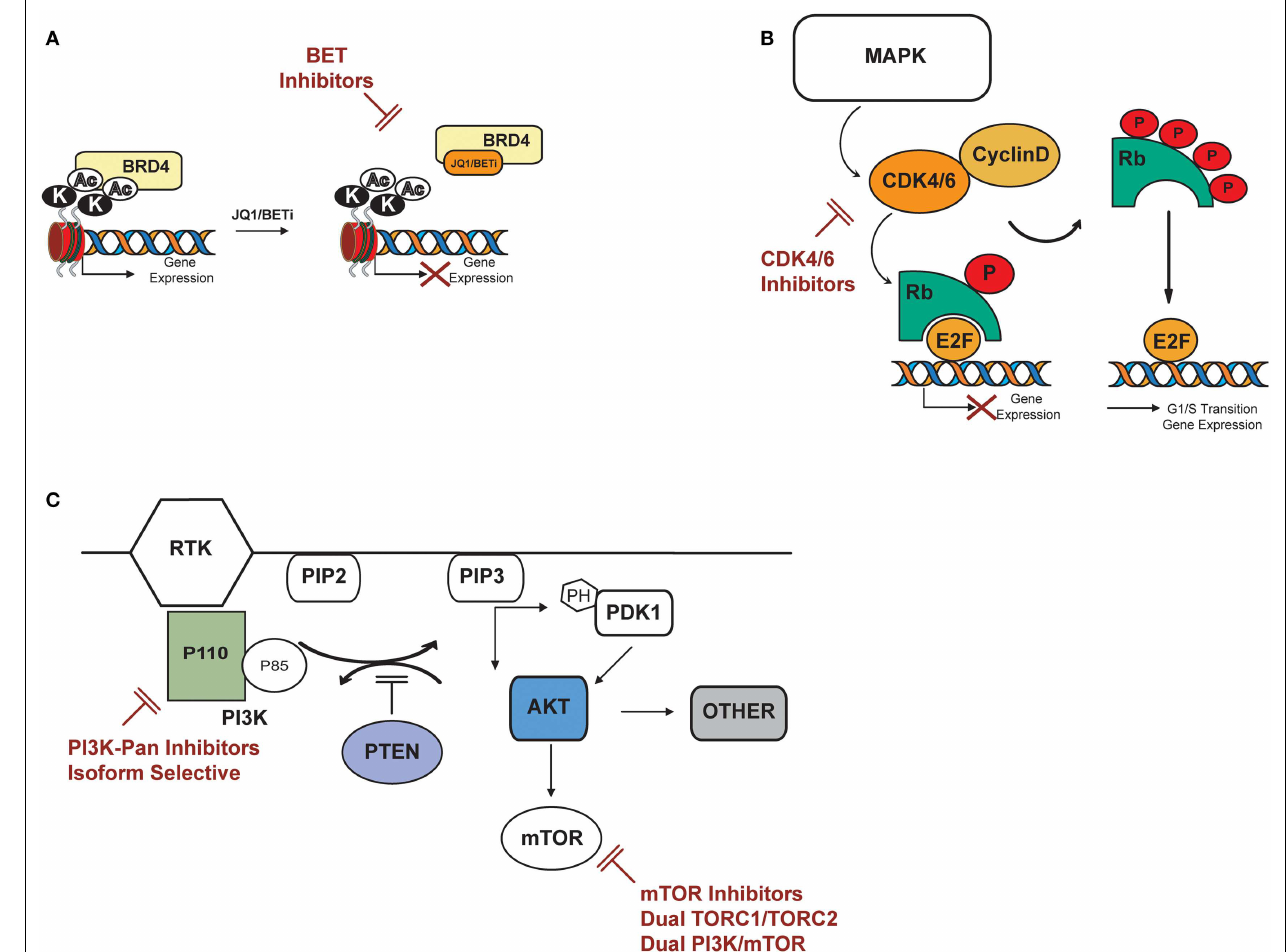
phosphatidylinositol-3,4 bisphosphate (PIP2). PIP3 binds to the pleckstrin homology (PH) domains of the 3 (cid:48) phosphoinositide-dependant kinase (PDK-1) and AKT causing both proteins to translocate to the cell membrane where they are subsequently activated. AKT activation stimulates metabolism, cell-cycle progression, survival and migration through phosphorylation of many physiological substrates, including mTOR.The tumor suppressor PTEN inhibits PI3K signaling by the dephosphorylation of PIP3. AKT can activate mTOR directly by phosphorylation at S2448 or indirectly by inhibition of the tuberous sclerosis complexTSC2. Potential inhibitors of the above described pathway are indicated in